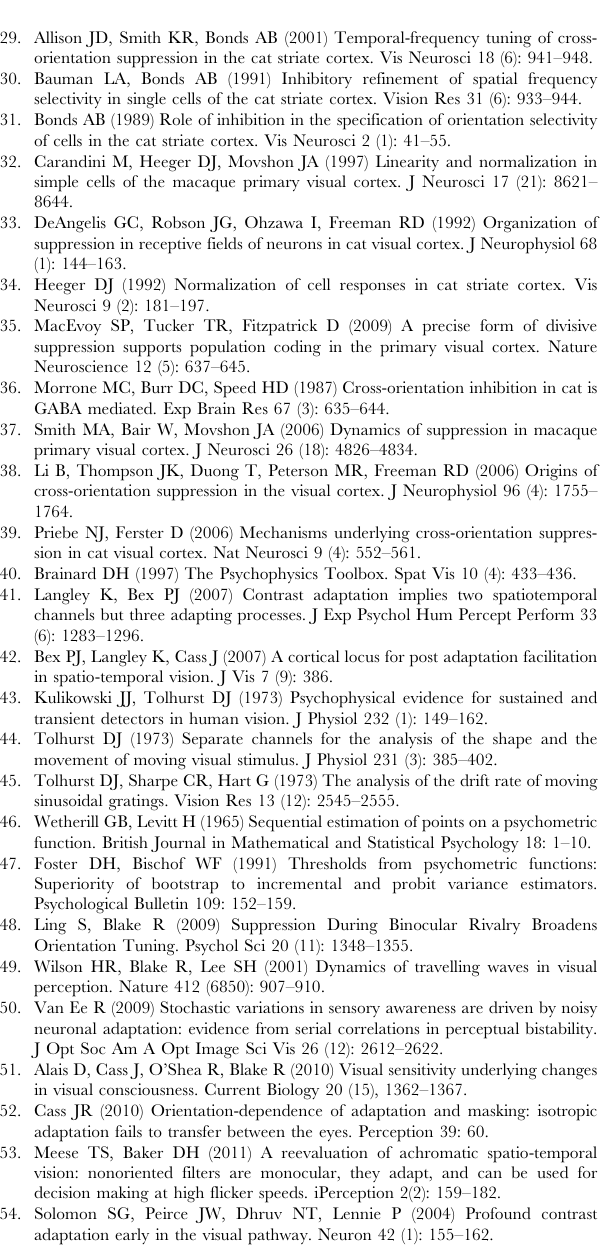
Figure S1 Mean monoptic threshold elevation estimates as a function of angular difference between adaptor and test stimuli with spatial frequencies of 0.25 and 2